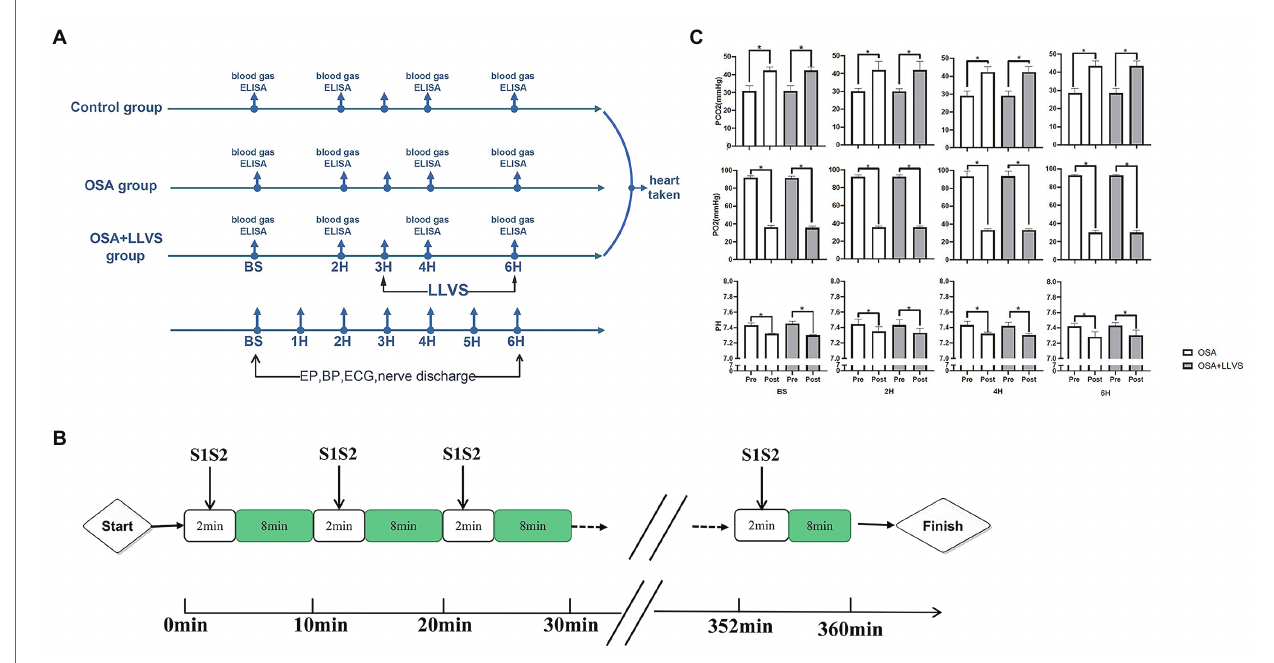
FIGURE 1 | Flow chart of the study protocol. (A) . Acute OSA protocol. (B) . Changes in blood gases pre- and post-apnea between the OSA and OSA+LLVS groups. (C) . * p < 0.05 vs. the pre-apnea; OSA, obstructive sleep apnea; LLVS, low-level vago-sympathetic trunk stimulation; EP, electrophysiology; BP, blood pressure; ECG, electrocardiography; PaO 2 , partial pressures of oxygen; PaCO 2 , partial carbon dioxide tension; ELISA, enzyme-linked immunosorbent assay; H, hours; min,